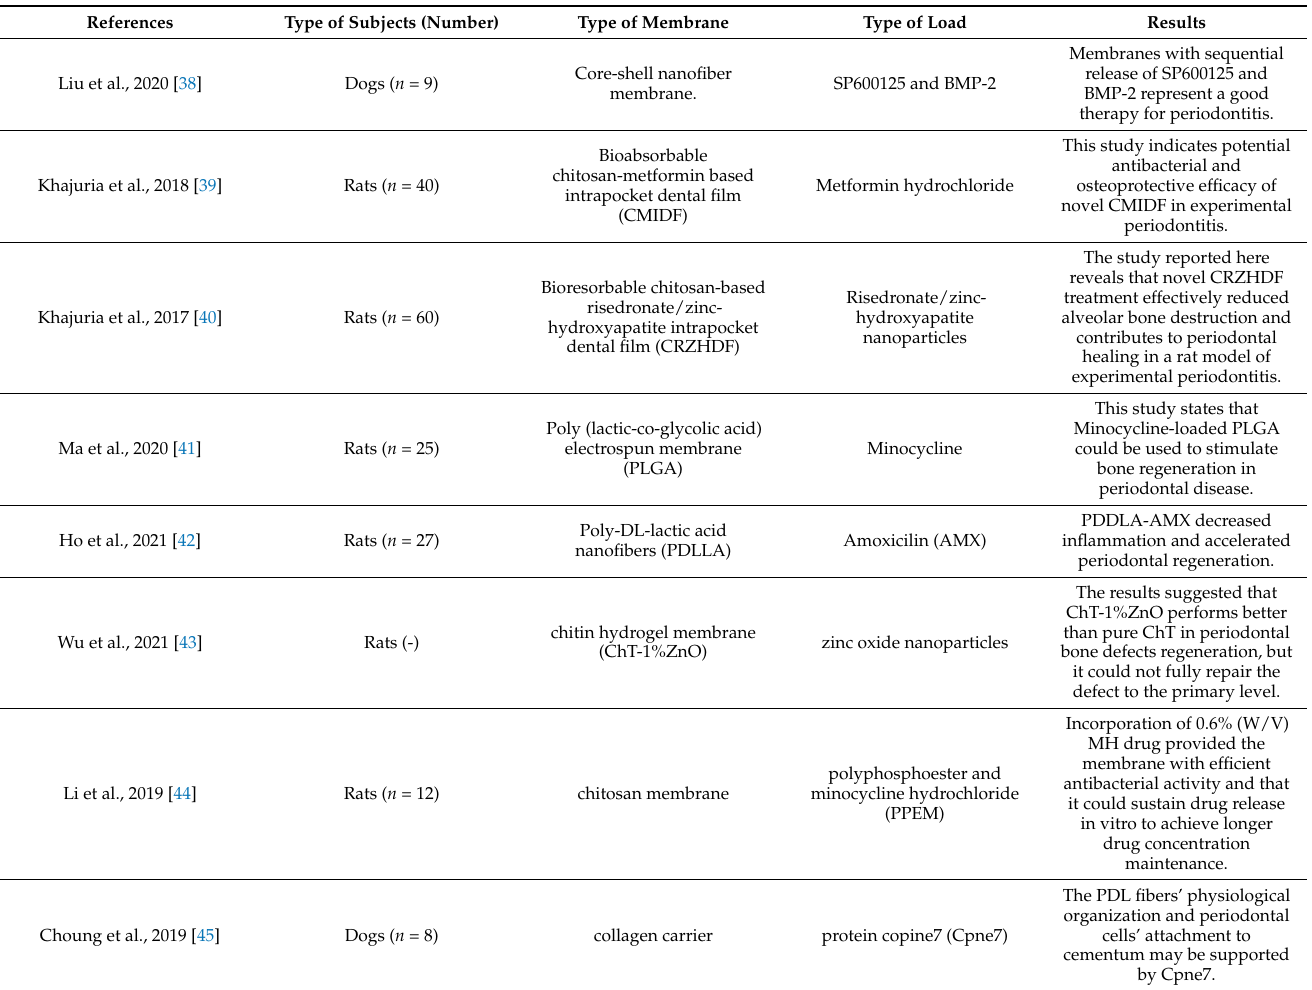
Table 3. Animal studies included in the